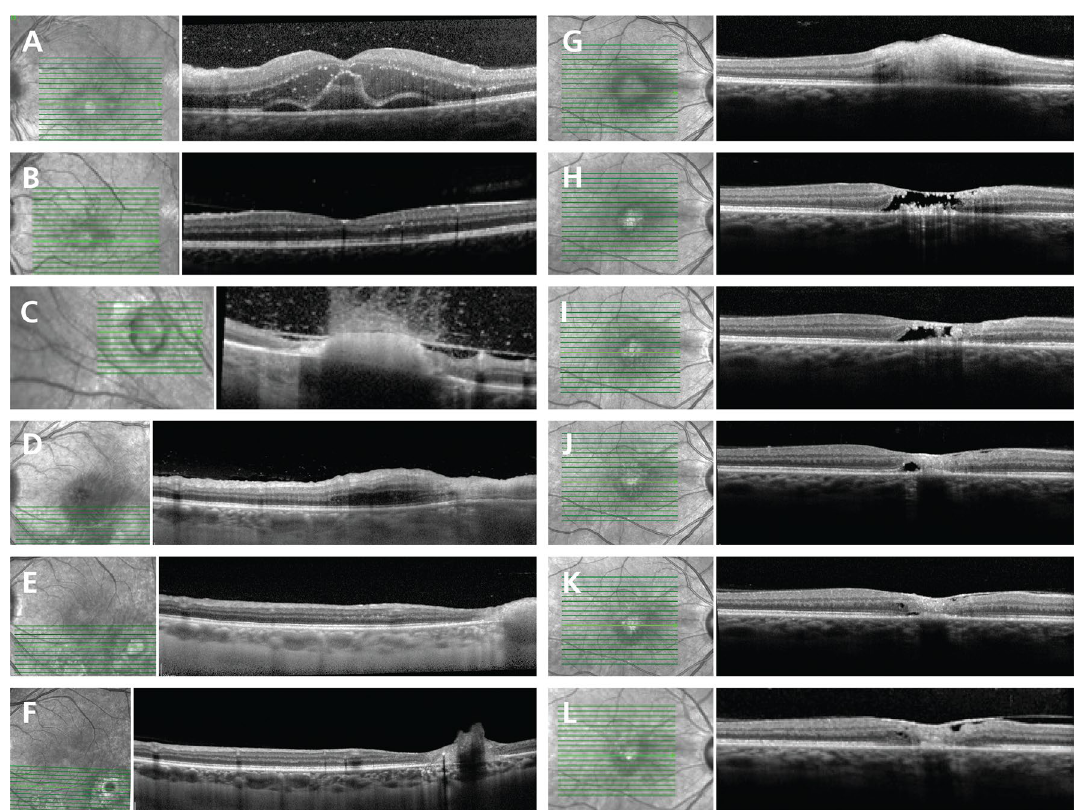
Figure 2. Macular oedema and evolution of retinal necrosis in TRC. ( A - C ) Macular oedema in TRC. ( A ) Patient presents with a superonasal focus of TRC in the left fundus, with hyperreflective dots in the vitreous cavity, small hyperreflective dots in outer plexiform layer, outer nuclear and photoreceptor layers, and marked intraretinal fluid at the macula with subfoveal fluid. Small hyperreflective dots are especially prominent in the outer plexiform and outer nuclear layers; ( B ) At 8 weeks post-presentation, the macular oedema had resolved, with widespread small hyperreflective intraretinal dots; ( C ) Lesion in zone 2 at 8 weeks after presentation. There are hyperreflective dots in the vitreous cavity, posterior hyaloid thickening and separation, full thickness retinal hyperreflectivity and subjacent choroidal hyporeflectivity. ( D – F ) Evolution of “coagulative necrosis" in TRC. SD-OCT scans in a patient with recurrent, IgM-negative TRC. ( D ) At presentation, there is full-thickness retinal hyperreflectivity, adjacent retinal thickening, preservation of retinal layers and outer retinal oedema; ( E ) At 4 weeks after presentation, revealing retinal hyperreflectivity with pronounced choroidal hyporeflectivity. Note adjacent retinal thinning, disorganization, and RPE hyporeflectivity with choroidal shadowing; ( F ) At 6 months after presentation, dense retinal hyperreflectivity associated with choroidal shadowing and RPE atrophy. ( G - L ) Evolution of “liquefactive necrosis” in TRC . SD-OCT scan of right macula in a patient presenting with zone 1, primary T. gondii IgM-positive TRC. ( G ) At presentation, demonstrating full-thickness retinal hyperreflectivity, thickening and loss of retinal organization. Note lack of hyperreflective dots in the vitreous cavity; ( H ) At 7 days post-presentation. Necrosis demonstrated by large retinal hyporeflective space within retina and preservation of the ILM, and RPE thickening; ( I ) At 2 weeks after presentation, hyporeflective space is smaller; ( J ) Week 5 after presentation, disorganized retinal tissue and RPE thickening; ( K ) Nine weeks after presentation, necrosis has resolved and is replaced with granular disorganized tissue; ( L ) At 4 months post-presentation, showing partial separation of the posterior hyaloid, ERM formation, disorganized retinal tissue, thickened RPE and focal choroidal hyporeflectivity. Abbreviations: SD-OCT = spectral domain optical coherence tomography, TRC = toxoplasmic retinochoroiditis, Ig = immunoglobulin, RPE = retinal pigment epithelial/epithelium, ILM = internal limiting membrane, ERM = epiretinal